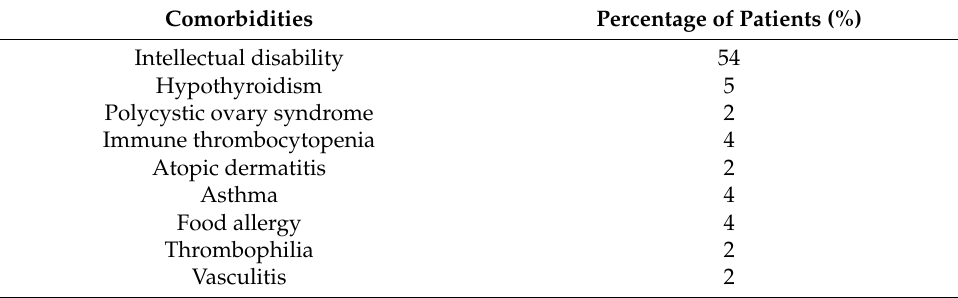
Table 3. Comorbidities in DS